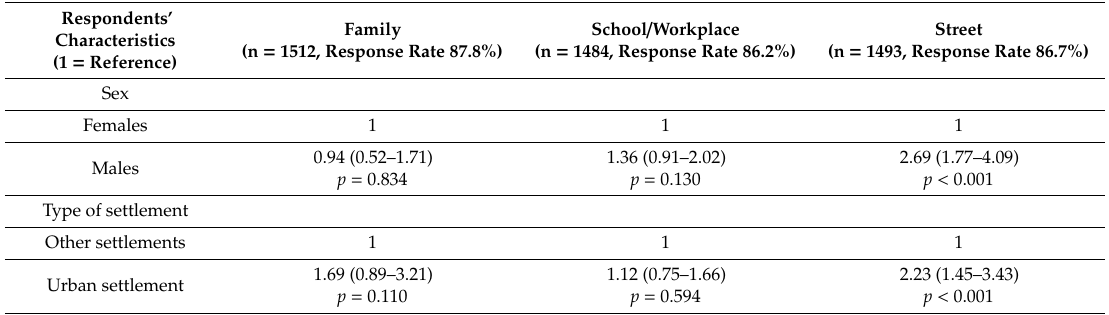
Table 3. Determinants and predictors for violence victimization (Odds Ratios and 95% Confidence Interval) by place, youth (15–24 years) in Serbia,